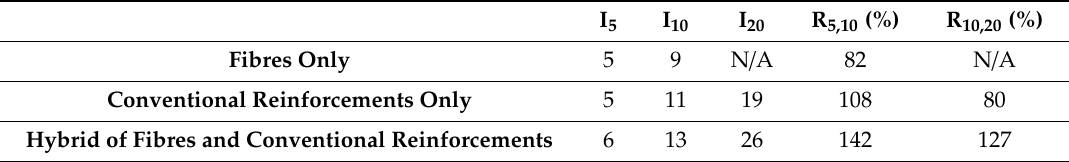
Table 7. Average toughness indices and residual strength factors of the beams in torsion.